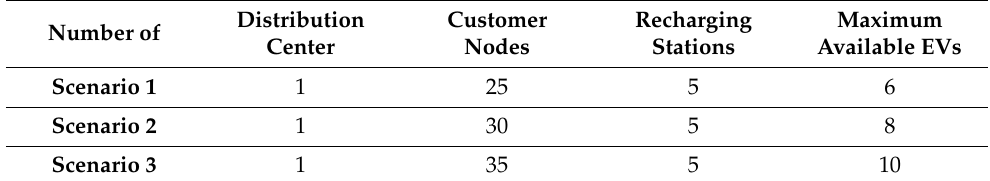
Table 5. Settings of three scenarios.